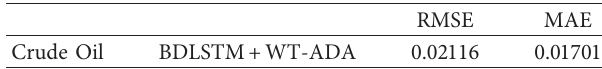
Figure 6: Prediction of Crude Oil price movement based on observations in the past 128 days. Time period (a) July 16, 2019, to January 27, Table 5: Simulation results obtained with the best configuration system for Crude Oil price. As evaluation criteria, RMSE and MAE are